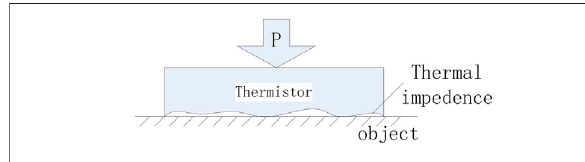
FIGURE 3 | Schematic diagram of thermistor contact thermal resistance.